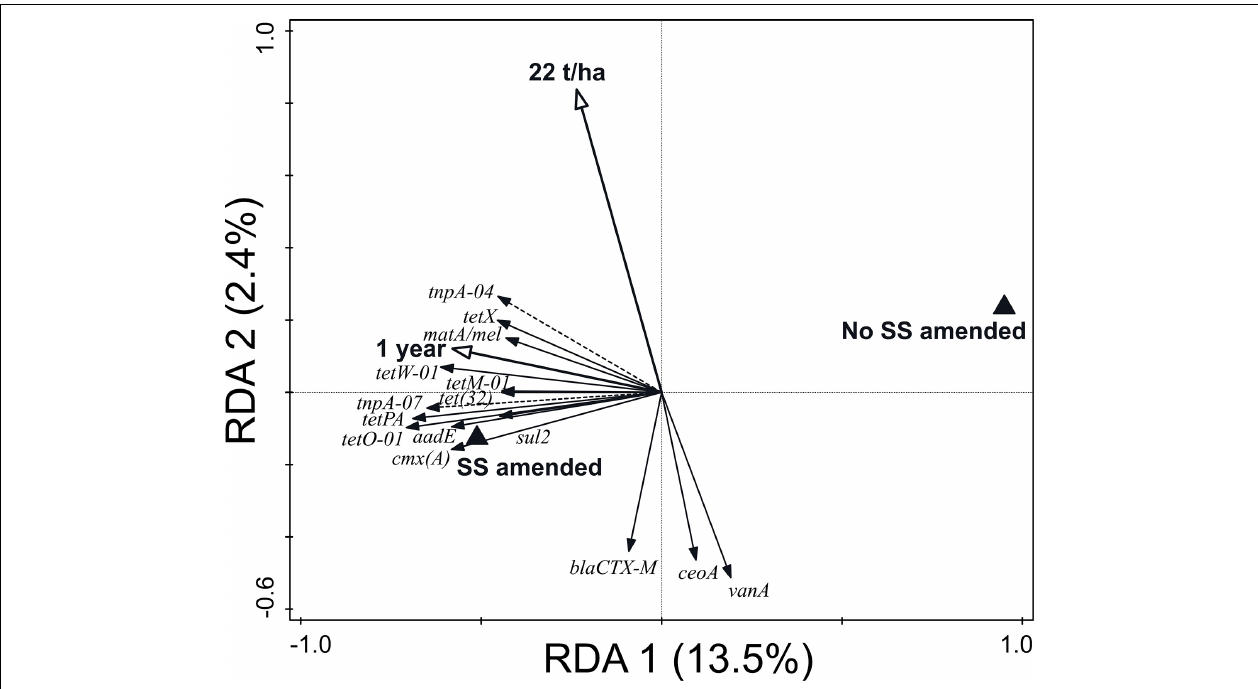
FIGURE 3 | Biplot of the RDA performed with SS management (i.e., dosage of application, elapsed time after the last application, and presence/absence of SS) as explanatory variables, ARGs and MGE-genes relative abundances as response variables, and field and current crop as covariates. Only statistically significant explanatory variables and response variables with the best fit are shown. The explanatory variables explained 23.1% of the variation in ARG and MGE-gene relative abundances.